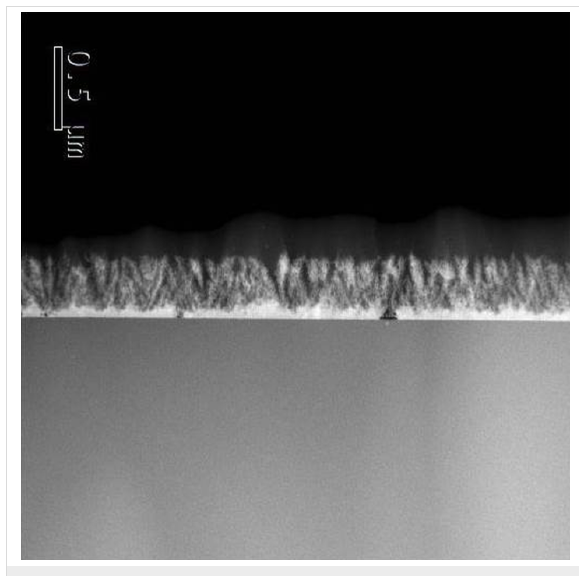
Figure 2: Cross-view TEM image of Ti (430-190).